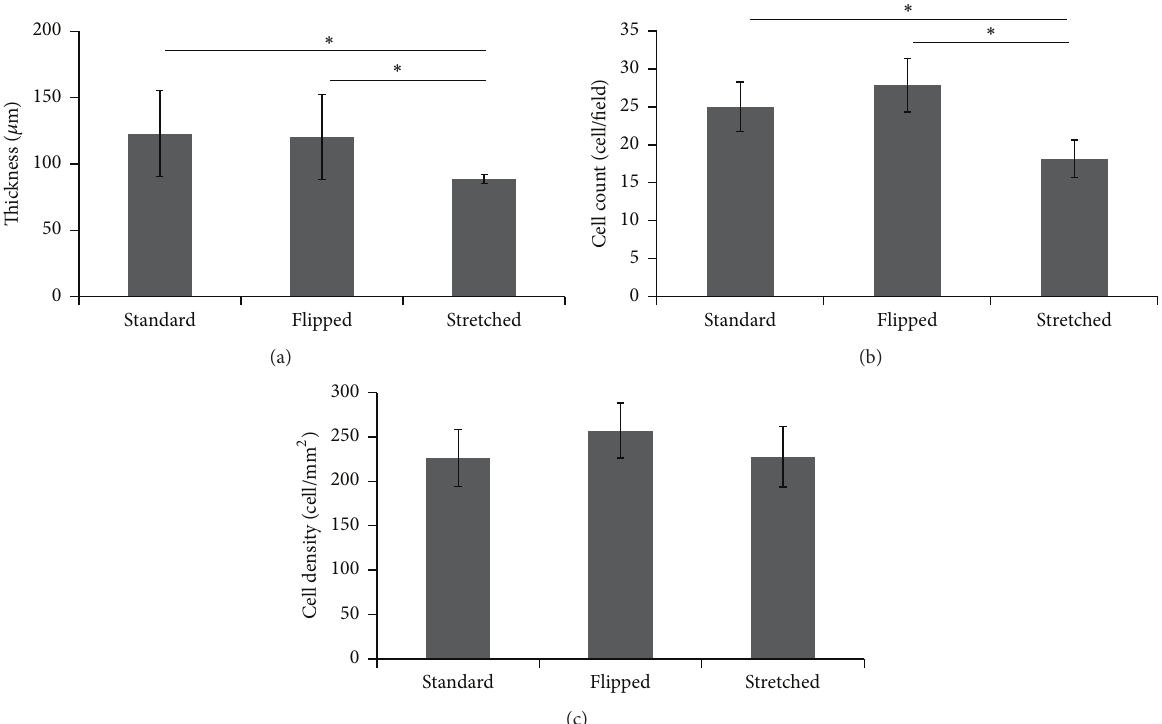
Figure 6: “Stretched” cell culture conditions reduced the thickness of the tissue and the cell count. Asterisks indicate when statistically significant differences were found (i.e., 𝑝 < 0.05 ). (a) Thickness of the tissue was determined using photographs of slices stained with Masson’s trichrome. (b) Cell count was also determined from the same photographs. (c) Cell density was determined by dividing the number of cells counted inside the tissue per area of this